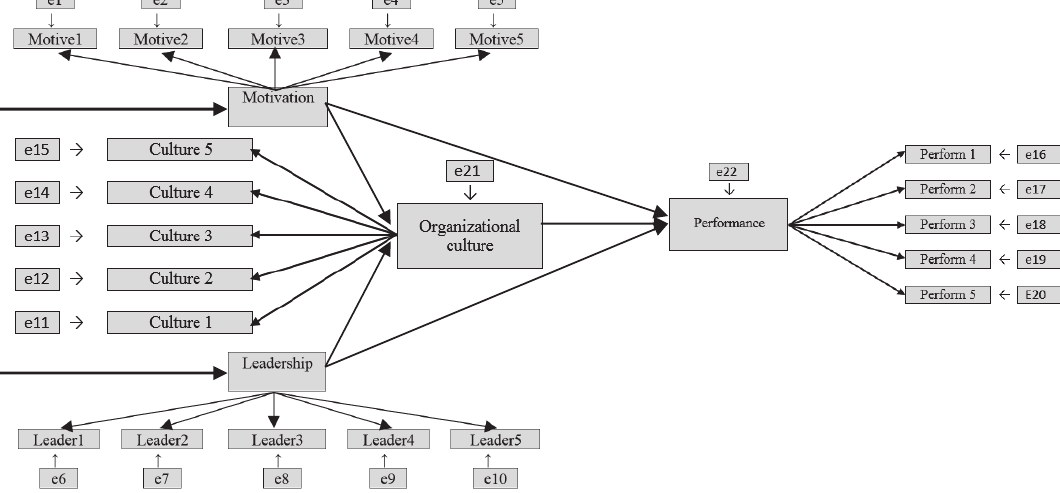
Fig. 1. Causality Model Motivation, Leadership, Organizational Culture and Performance Variables